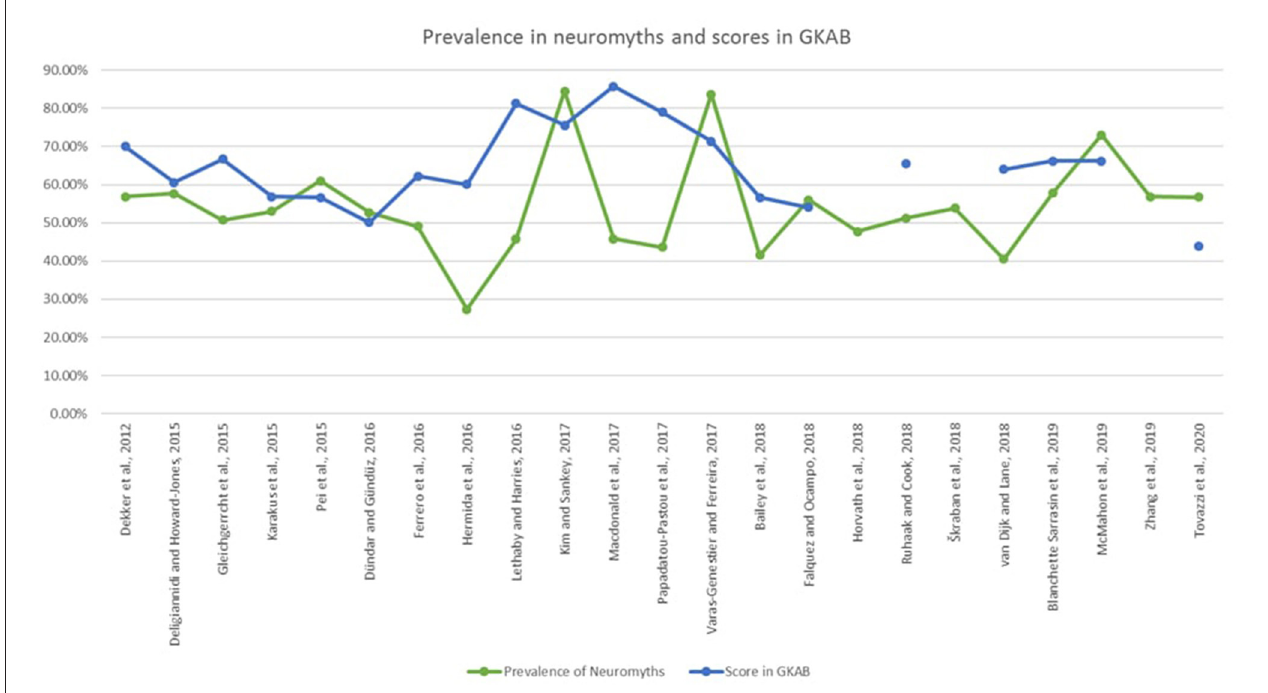
FIGURE 6 | Prevalence of neuromyths and scores in GKAB from 2012 to